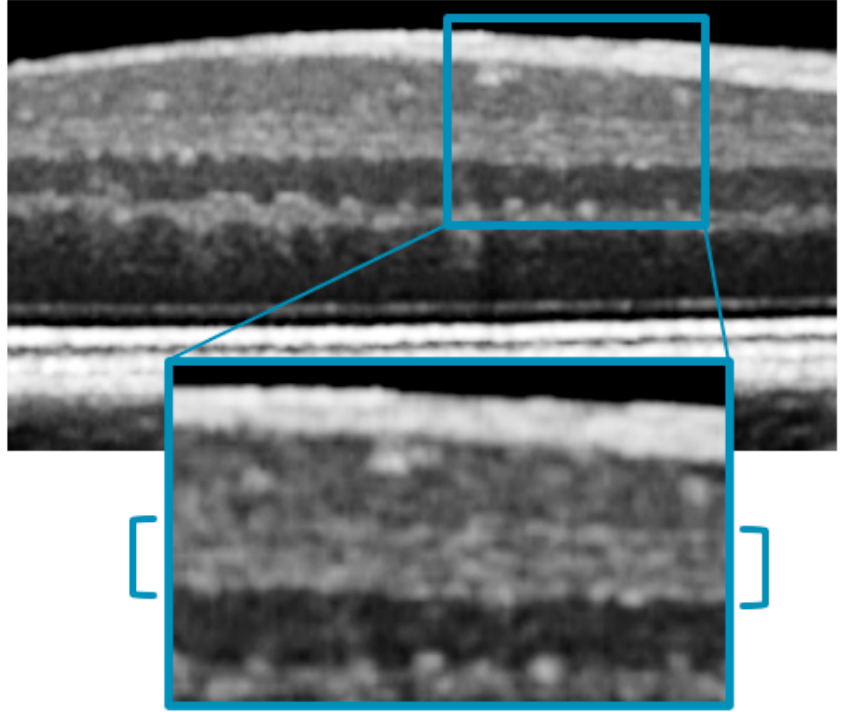
Figure 6. Magni fi cation of a 20 kHz OCT scan, showing the visible pentalaminar pa tt ern of the inner plexiform layer (IPL). plexiform layer